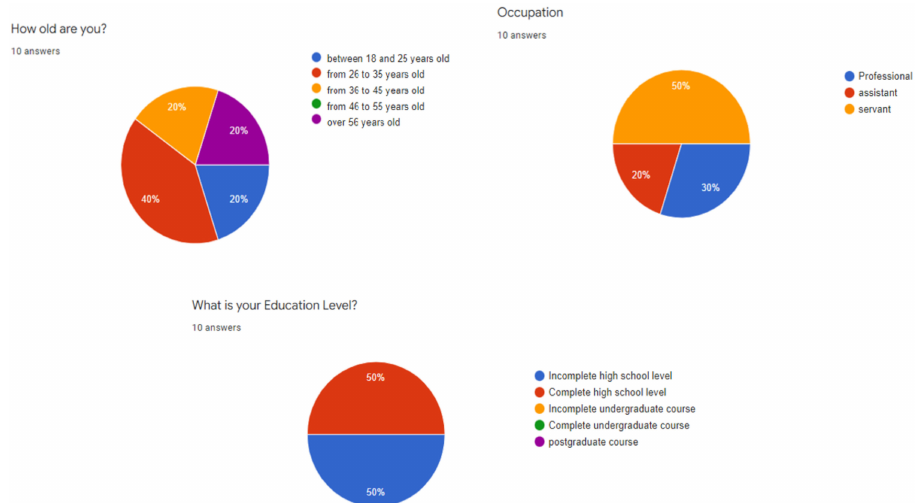
Figure 6. Profile of the sample of workers.